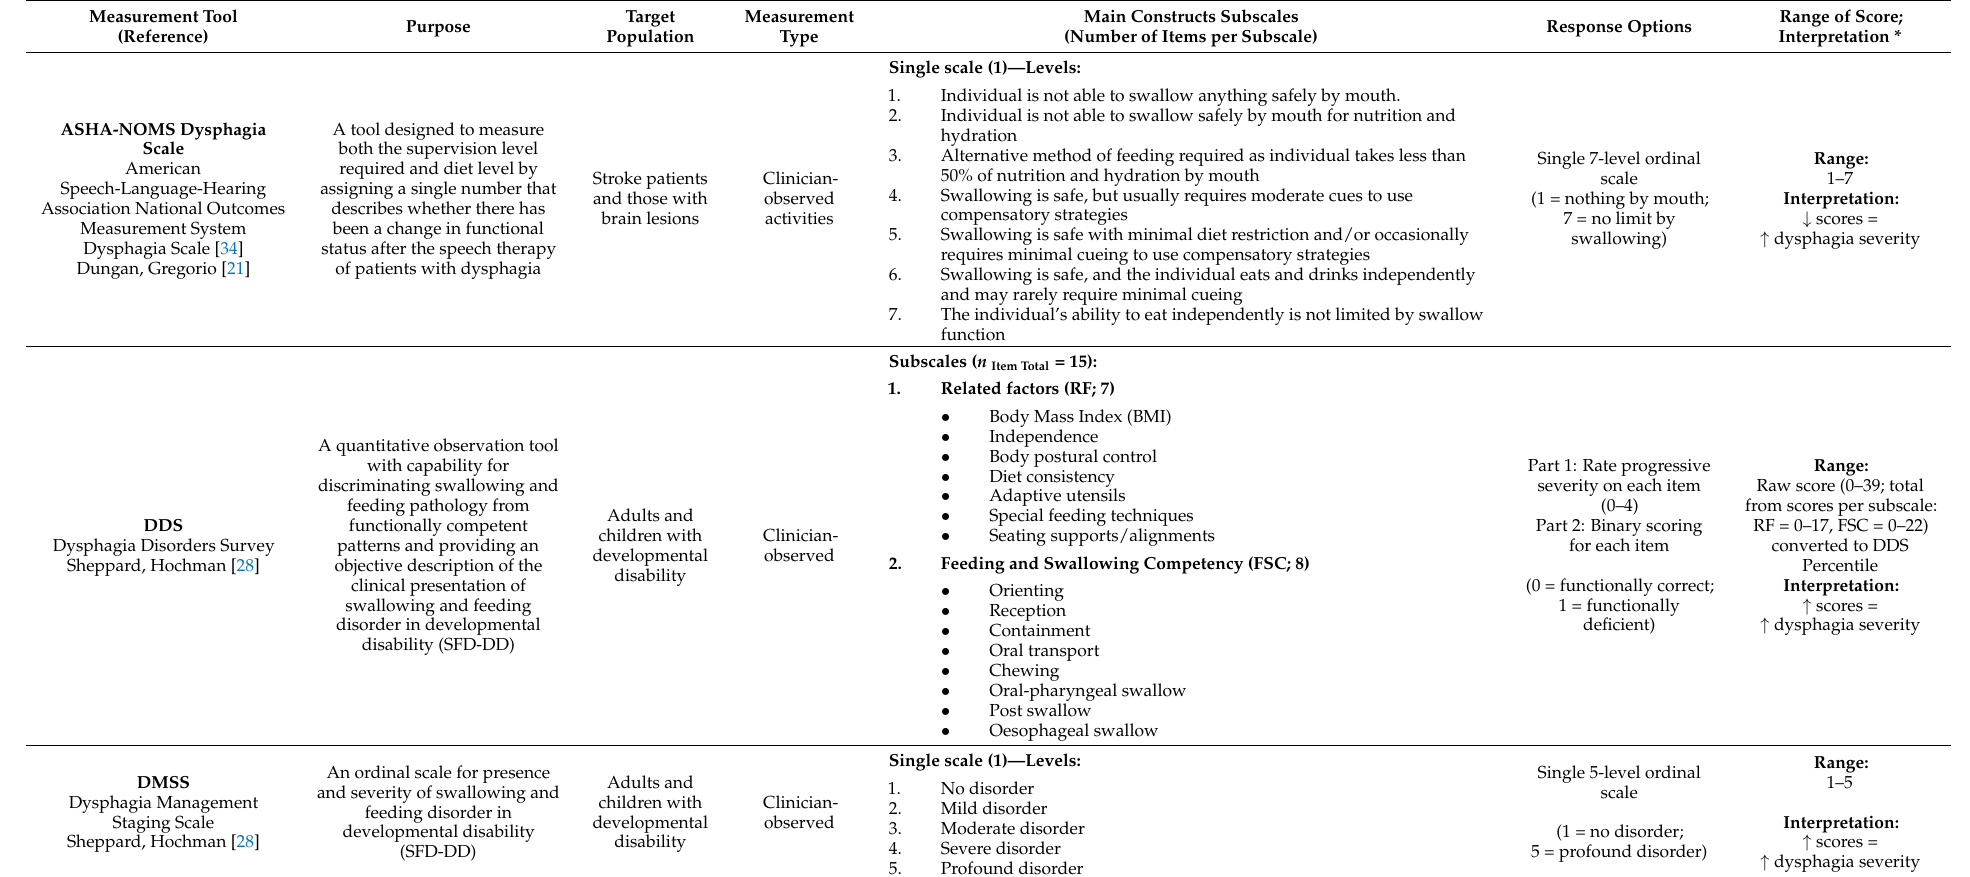
Table 2. Characteristics of the included